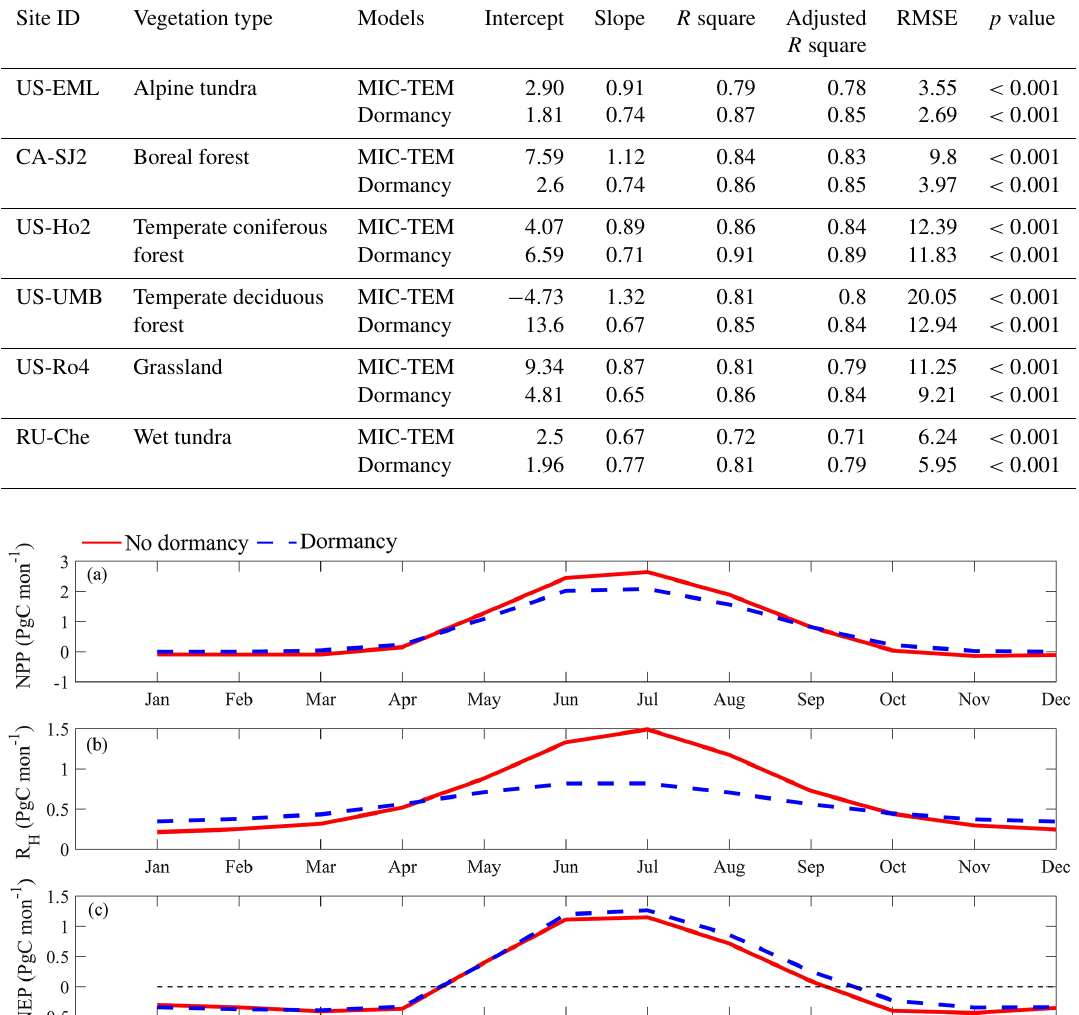
Table 6. Model validation statistics for the dormancy model and MIC-TEM at six sites with R H data.